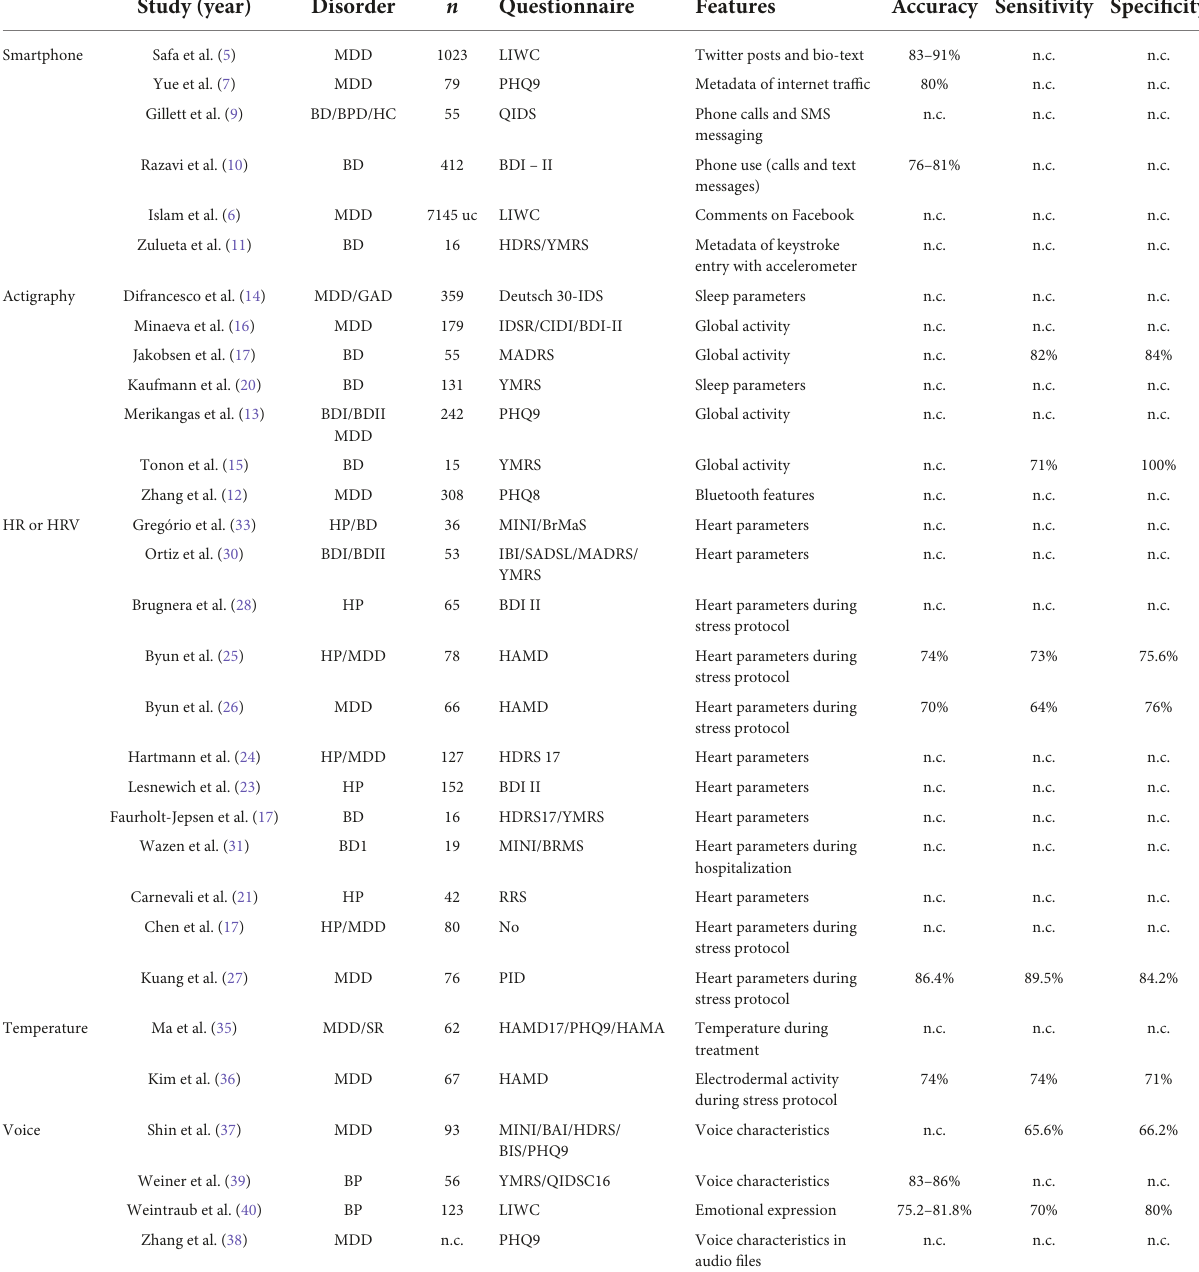
TABLE 1 Unimodal data